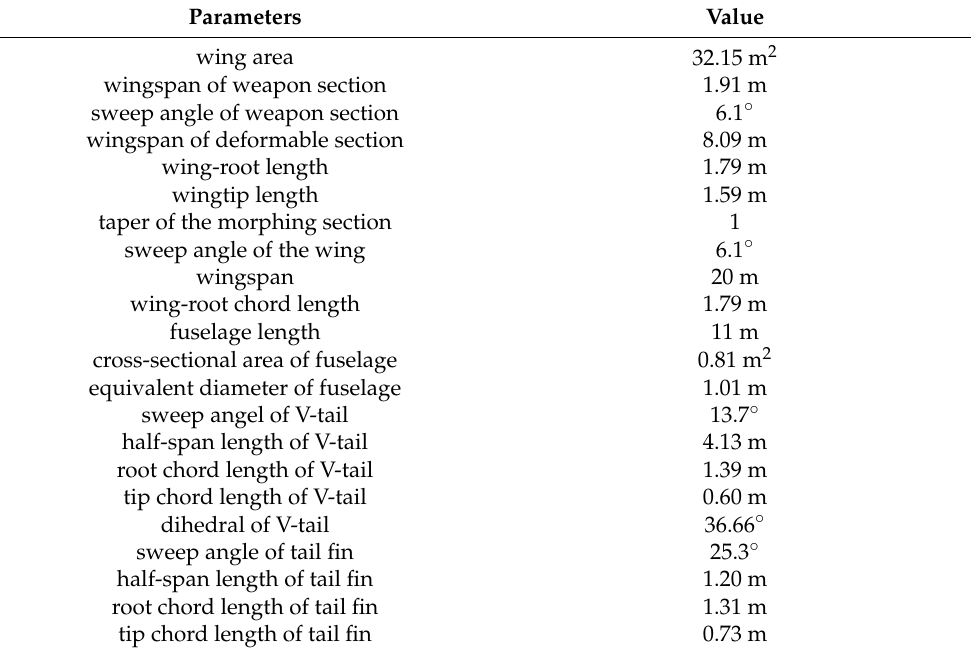
Table 1. Overall design parameters of wing, tail and fuselage.